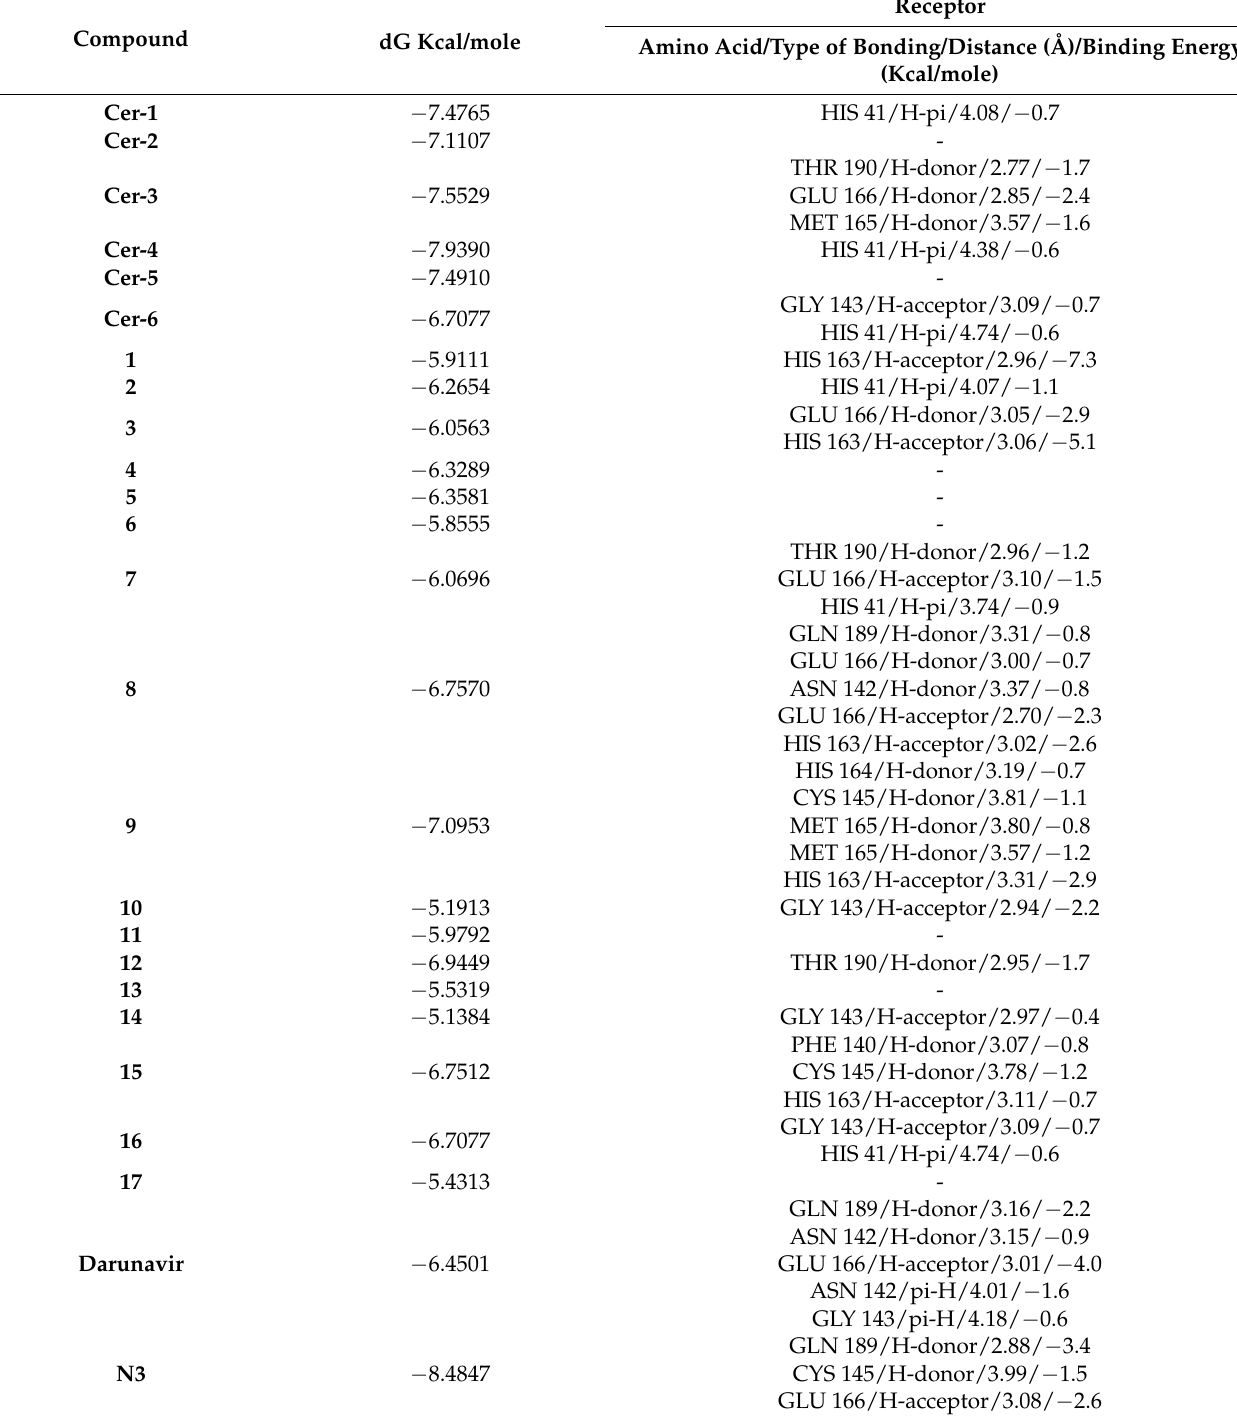
Table 5. Receptor interaction of isolated ceramides, compounds 1–17 , darunavir and N3 into the SARS-CoV-2 M pro .